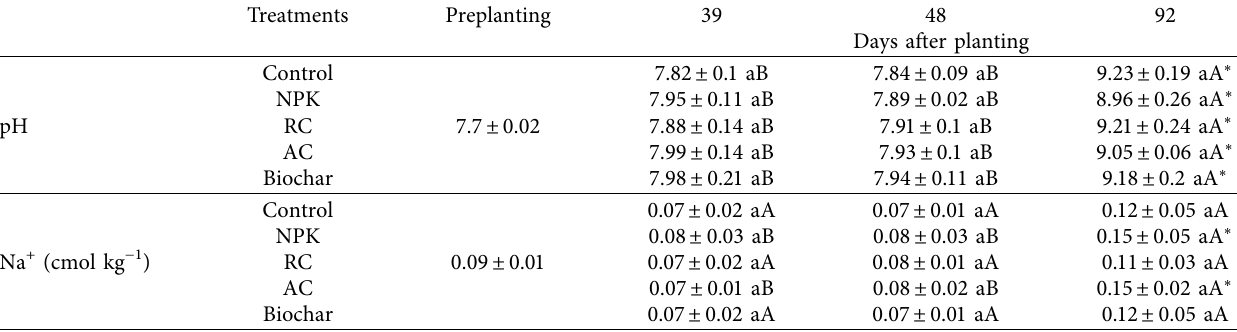
Table 4: Soil pH and sodium concentration during the growing season of sweet potatoes at preplanting and 39, 48, and 92 days after